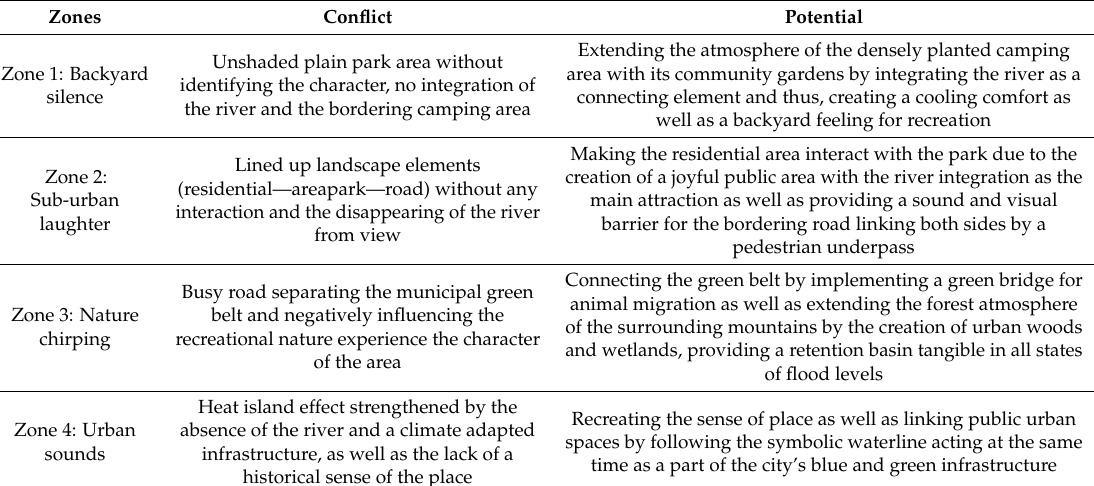
Table 1. The conflicts and potentials of the study